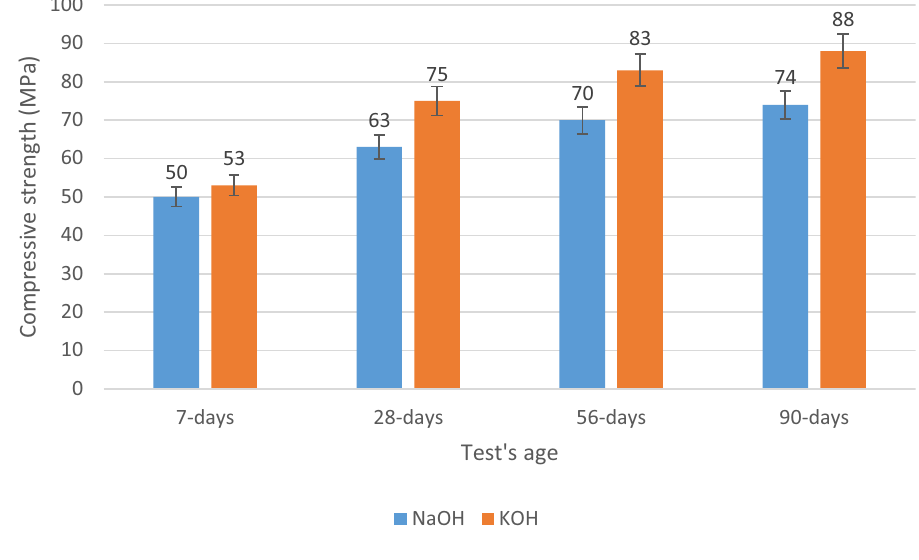
Fig. 9 The compressive strength development of mor- tars with